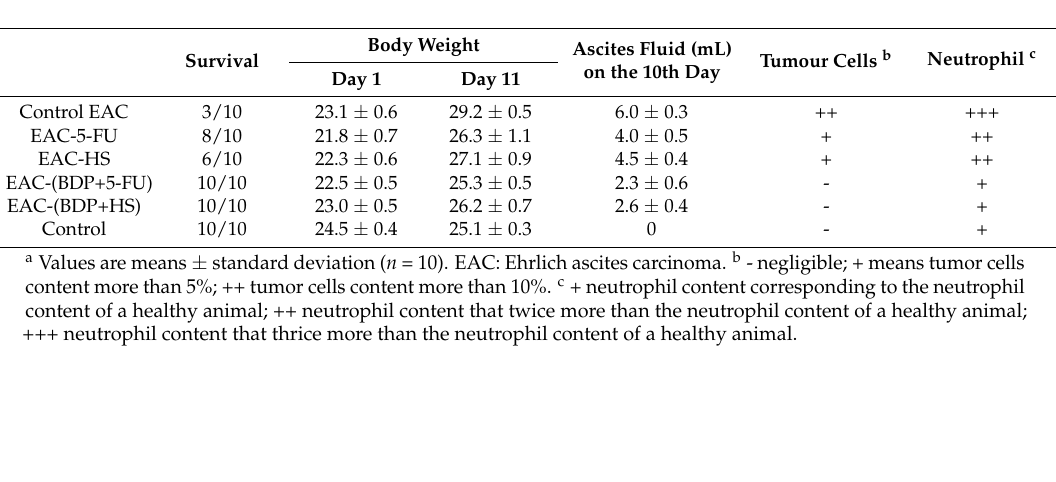
Table 7. The effects of 5-FU, HS, and the combination drugs of BDP + 5-FU and BDP + HS on the biological parameters of EAC-bearing mice on the 11th day a